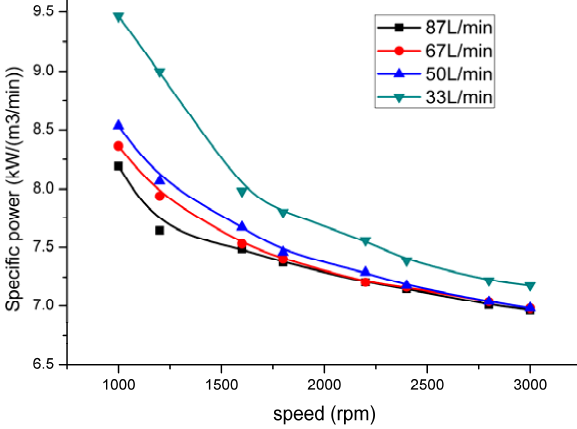
Figure 9. Variation of specific power with different rotation speeds.